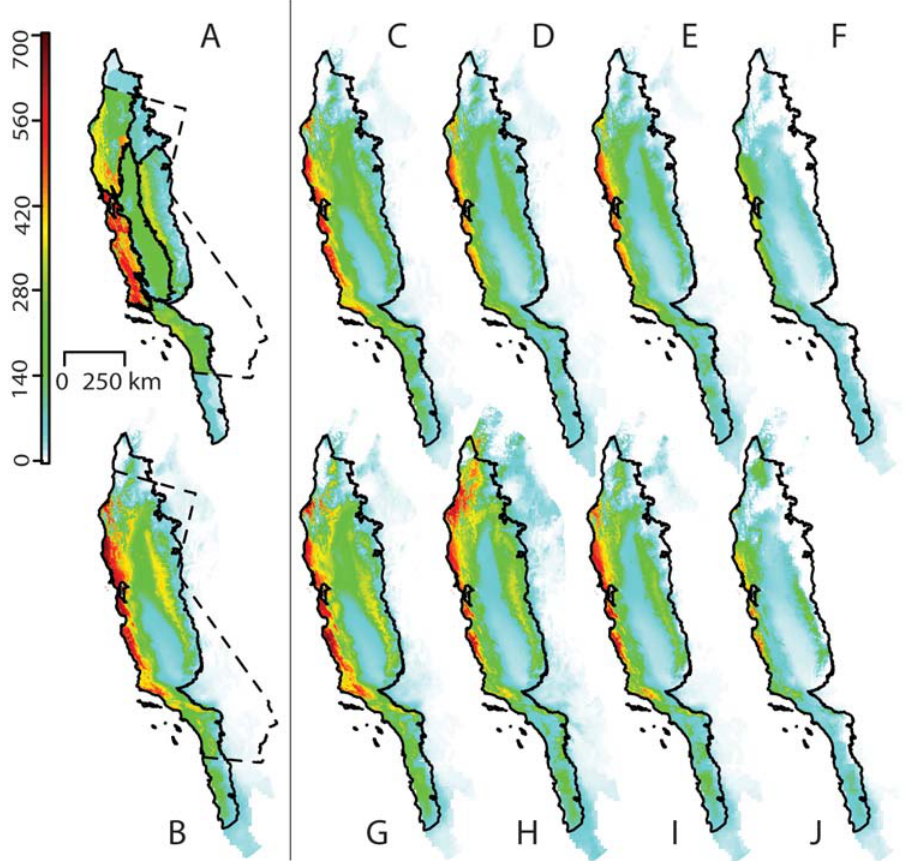
Figure 2. (A) Present diversity from range maps for all California Floristic Province endemic species (2387). (B) Projected present diversity from the Multi-level Generalized Linear Model for all species with . 2 specimens (2068). (C–J) Projected diversity 80 years from now modeled with increasingly increasing amounts of future climate change: (C–F) Plants cannot disperse. (G–J) Plants can disperse to all suitable areas. (C, F, G, H) Simulations based on the lower sensitivity PCM model. (E, F, I, J) Simulations based on the higher-sensitivity HadCM3 model. (C, E, G, I) Lower emissions scenario (B1). (D, F, H, J) Higher emissions scenario (A1FI).